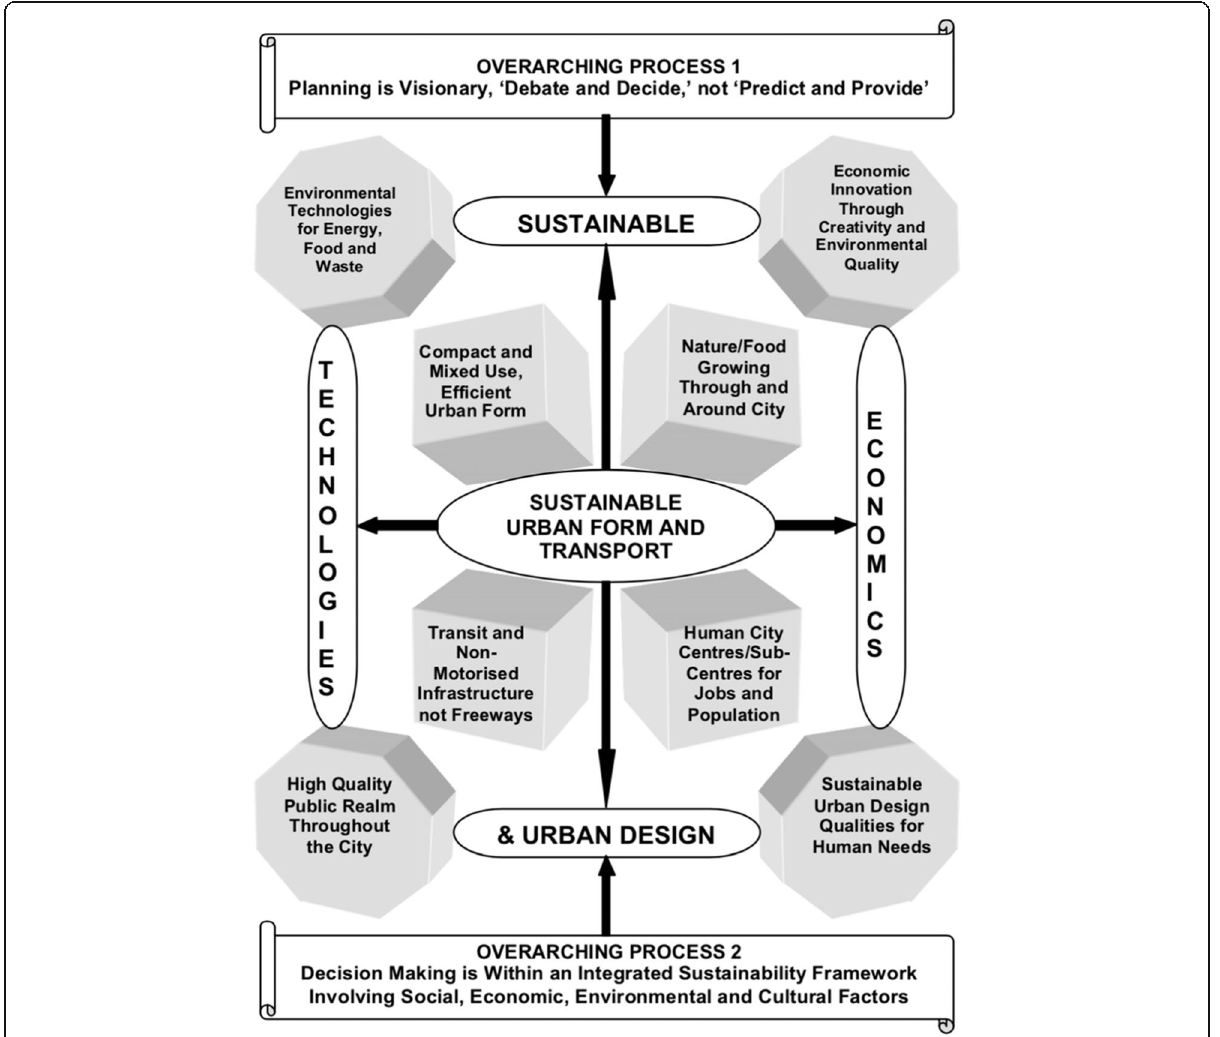
Fig. 1 A conceptual model for the eco-city based on 10 key principles in urban planning, urban transport, urban design, and planning process considerations. Source: Kenworthy